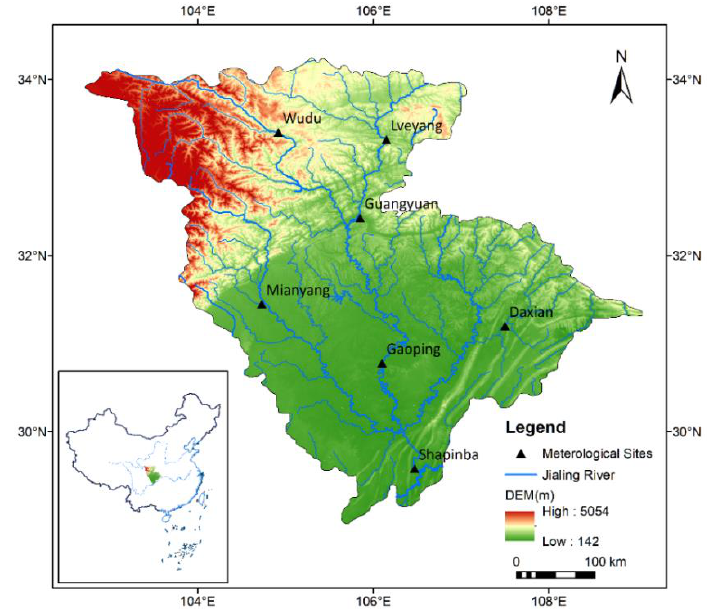
Figure 1. The geographical location of the study area.